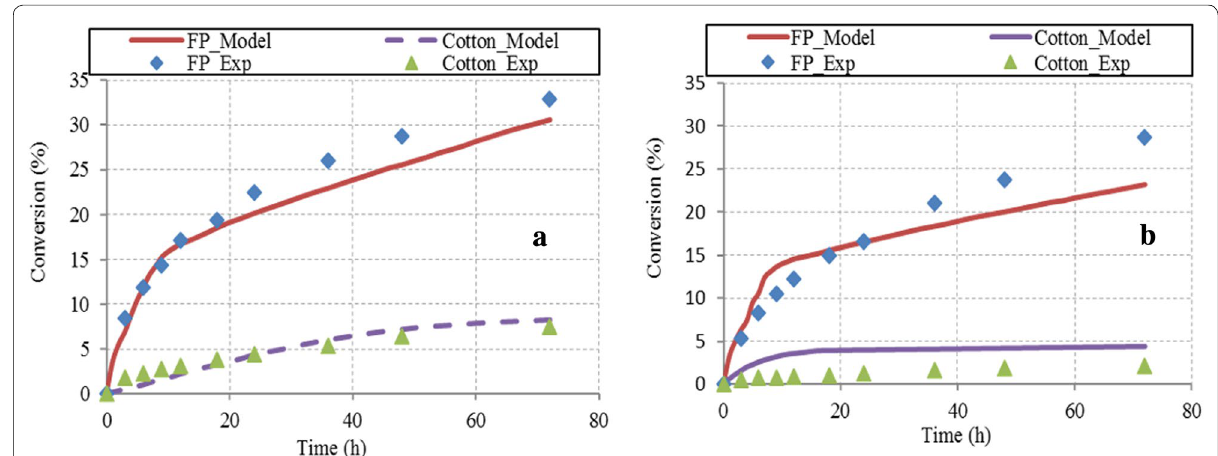
Fig. 14 Effect of cellulose structural properties on hydrolysis: cellulose conversion during hydrolysis of filter paper and cotton (25 g/L) by action of a CBH I at loading of 10 mg/g cellulose b CBH II at loading of 10 mg/g cellulose